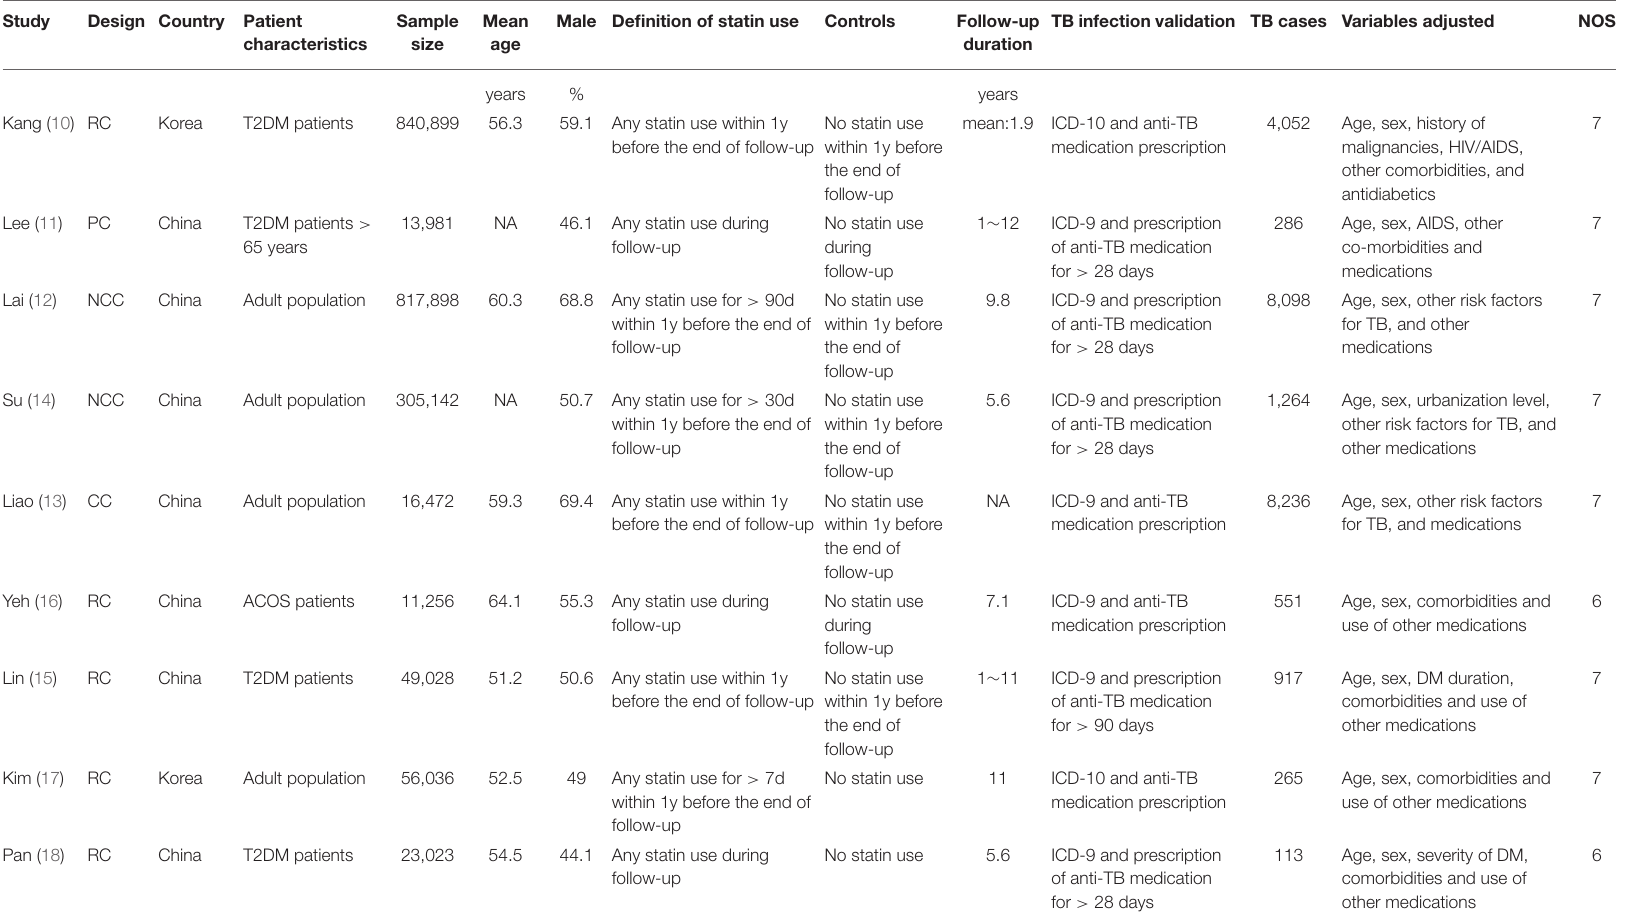
TABLE 1 | Characteristics of the included studies.